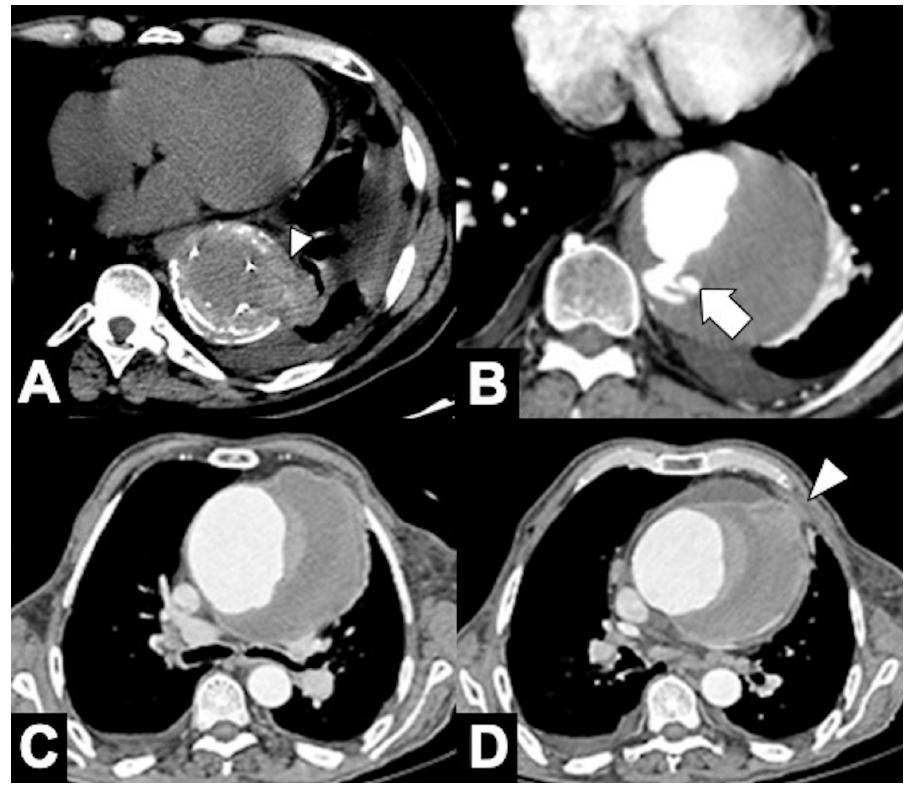
Figure 12. CTA findings in impending rupture of the thoracic aorta aneurysms. ( A ) Missing calcium sign (arrowhead). ( B ) Thrombus fissuration (arrow). ( C ) Hyperattenuating crescent sign, periaortic stranding sign, and contour irregularity of the aneurysm. ( D ) Periaortic fat stranding blurs a focal area of the mediastinum and extends to the chest wall representing an inflammatory process (arrowheads) [111].